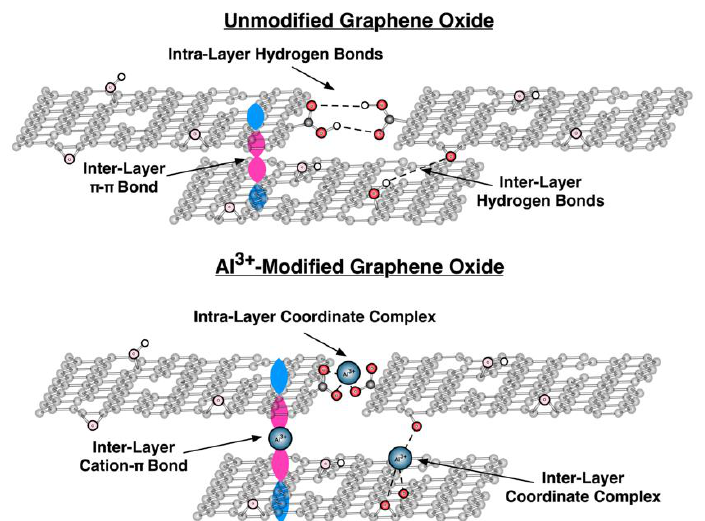
Figure 1. Schematic of the nanochannel in both unmodified ( top panel ) and Al 3+ -modified ( bottom panel ) GO membranes. The addition of Al 3+ to the GO membrane results in an increase in the inter- layer distance and a decrease in the intra-layer spacing.